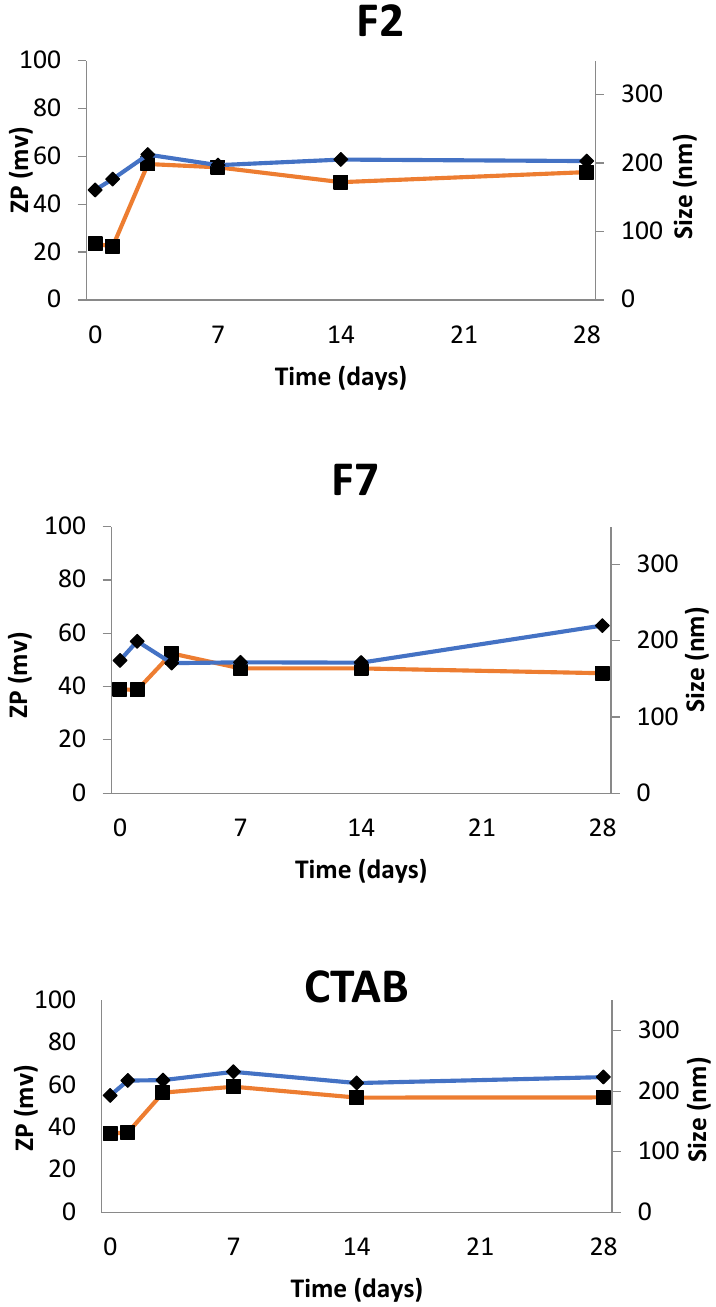
Figure 8. Mean size and zeta potential (ZP) recorded for the formulations F2, F7, CTAB-based nanoemulsion containing TA, over a period of 28 days.